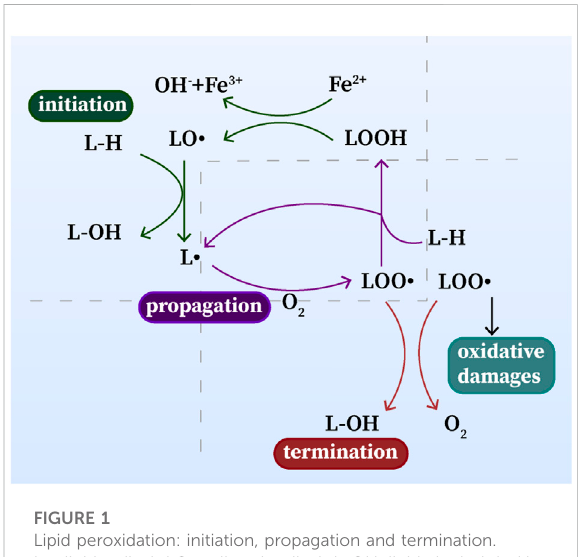
FIGURE 1 Lipid peroxidation: initiation, propagation and